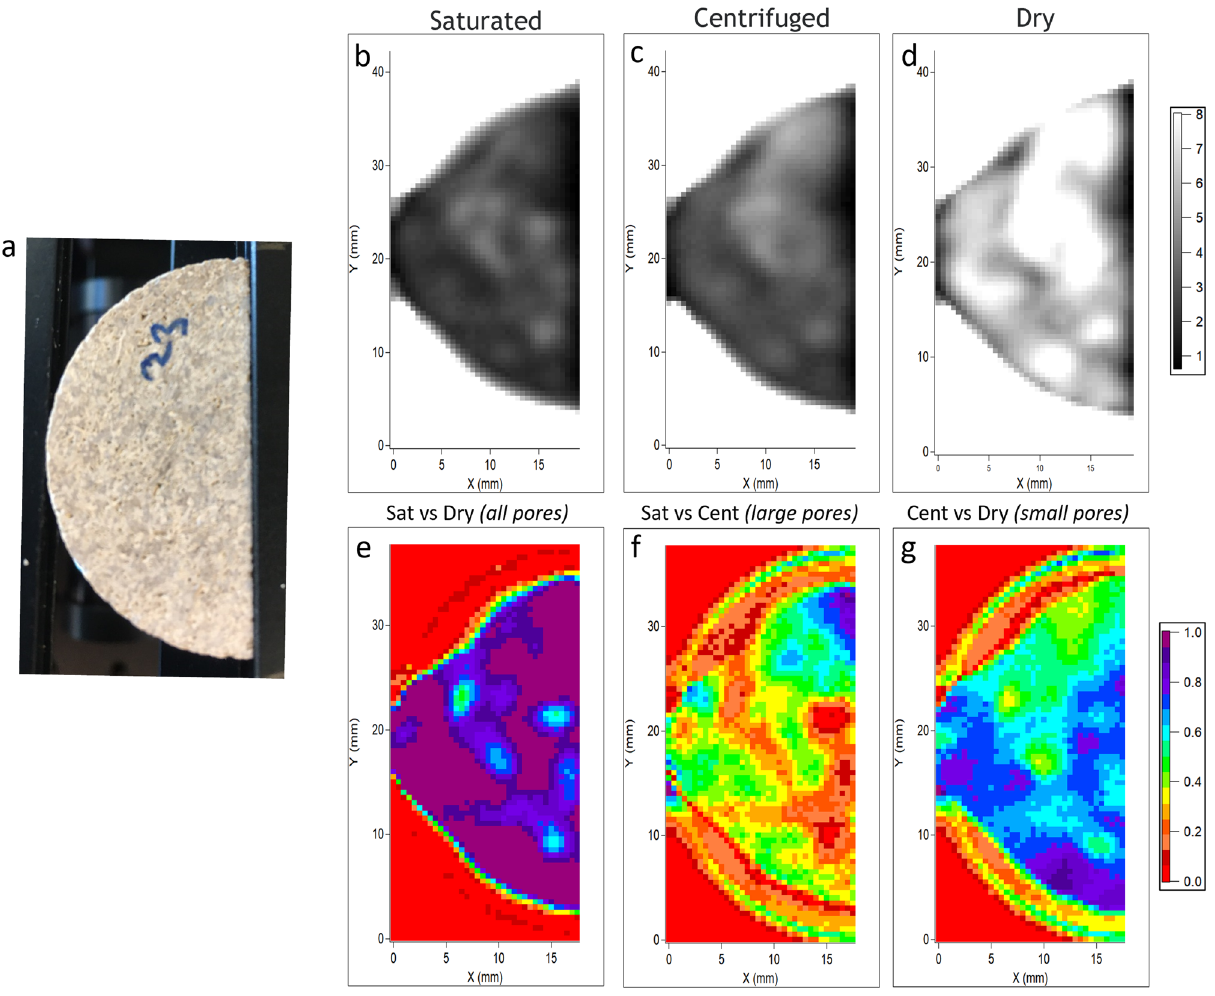
Figure 3. Attenuation and attenuation difference THz maps of Sample 3 (4 mm thick) as representative examples of the data for all samples. ( a ) photo, ( b – d ) normalized attenuation maps of the saturated, centrifuged, and dry samples, and ( e – g ) difference maps between the saturated and dry, saturated, and centrifuged, and centrifuged and dry attenuation maps to represent the spatial variation of the saturated pores, macropores ( d p > 1 µm), and micropores ( d p < 1